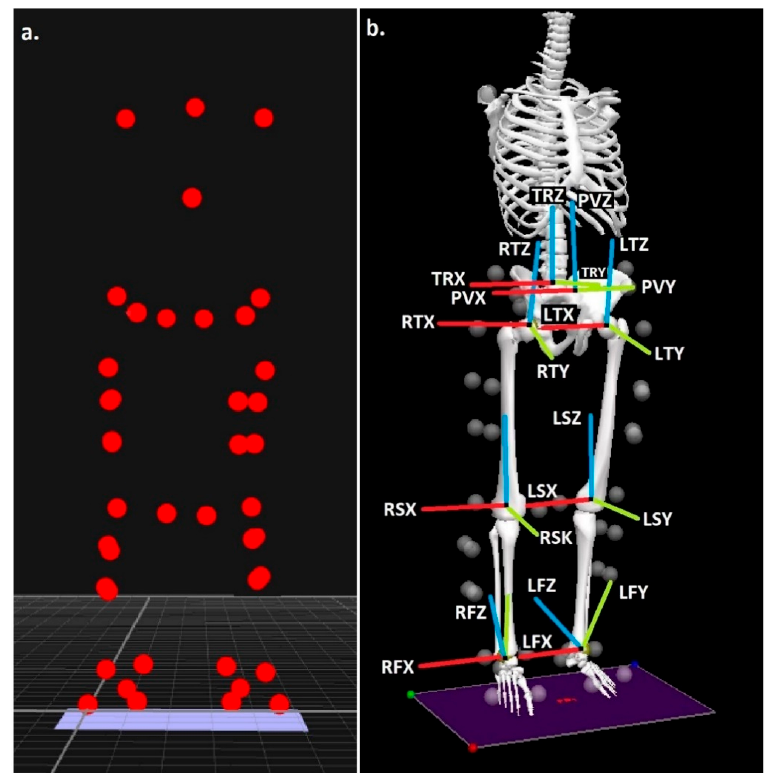
Figure 1. ( a ) Experimental marker locations and ( b ) trunk, pelvis, thigh, shank, and foot segments, with segment co-ordinate system axes (R = right and L = left), (TR = trunk, P = pelvis, T = thigh, S = shank, and F = foot), (X = sagittal, Y = coronal, and Z = transverse planes).